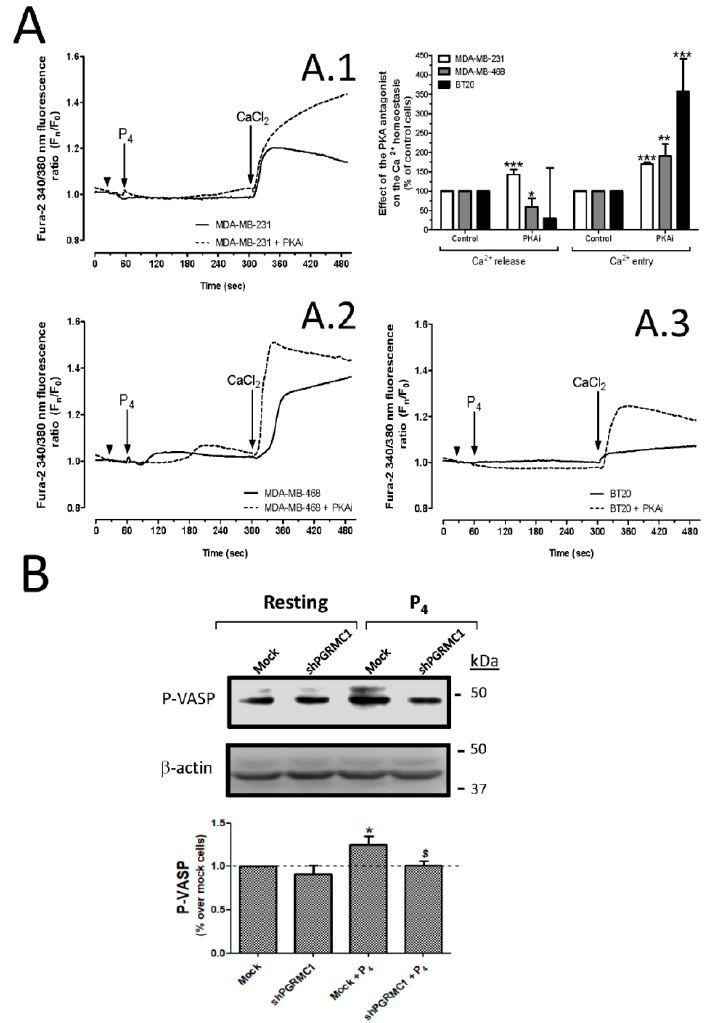
Figure 6. Protein kinase A (PKA) activation by progesterone (P 4 ) impaired calcium (Ca 2+ ) entry in triple-negative breast cancer cells. MDA-MB-231 cells ( A.1 ), MDA-MB-468 ( A.2 ), and BT20 cells ( A.3 ) were loaded with fura-2/AM. Single-cell imaging experiments were done using fura-2 loaded triple-negative breast cancer cells that were previously incubated for 30 min with the vehicle (black solid traces) or with 3 μ M of the PKA antagonist, KT5720 (PKAi, black dotted traces). Following this, the triple-negative breast cancer cells were stimulated for 4 min with P 4 (1 μ M) in a Ca 2+ -free HBS medium (75 μ M of ethylene glycol-bis( β -aminoethyl ether)-N,N,N ′ ,N ′ -tetraacetic acid (EGTA) was added, as indicated by arrowheads), and subsequently, P 4 -evoked Ca 2+ entry was visualized by adding 1 mM of CaCl 2 to the extracellular medium. Areas under the curves evoked by P 4 and CaCl 2 administration to the cells were determined, and they were used for comparison between both experimental conditions. The histogram represents the average of the percentage ± Standard error of the Mean (S.E.M.), resulting in the analysis of the areas under the curves corresponding to the P 4 -evoked Ca 2+ release and Ca 2+ entry evoked in the absence or presence of the PKA antagonist. The 20-30 cells from 6 independent experiments were considered during the analysis. *, **, ***: represent p < 0.05, p < 0.01, and p < 0.001 with respect to the control PKAi untreated cells, respectively. ( B ) The activation of PKA was analyzed by determining the phosphorylation rates of vasodilator stimulated phosphoprotein (VASP; at the Ser239) in MDA-MB-231 cells lacking or expressing the progesterone receptor membrane component 1 (PGRMC1), which were subsequently stimulated for 1 min with the vehicle or 1 μ M of P 4 . The image is representative of 3 independent transfections, and the bar graph